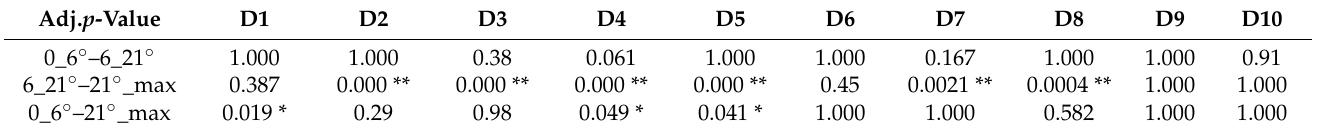
Table 3. Multiple tests of density metrics at different scanning angles.